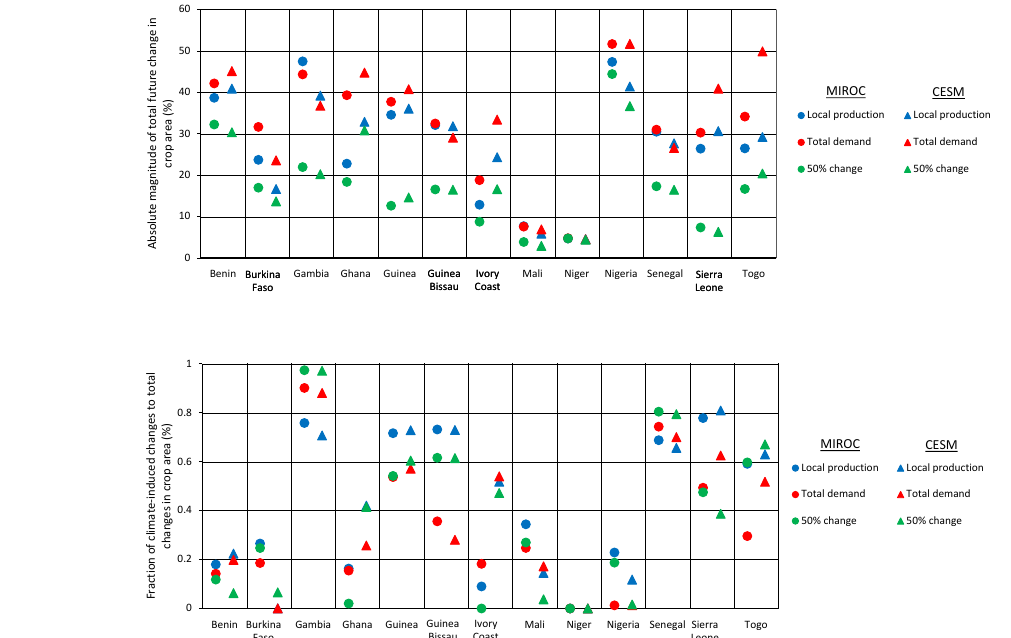
Figure 5. Country-average values of total changes in cropland coverage (top panel) and climate-induced changes as a fraction of total changes (bottom panel) according to three future scenarios of demand under the MIROC- and the CESM-driven regional climate.